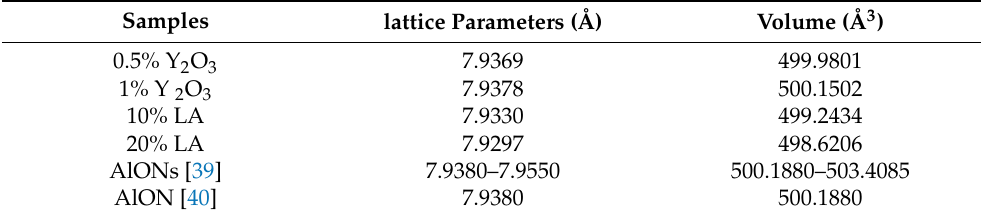
Table 2. Crystal lattice parameters of the AlON based ceramic samples with different